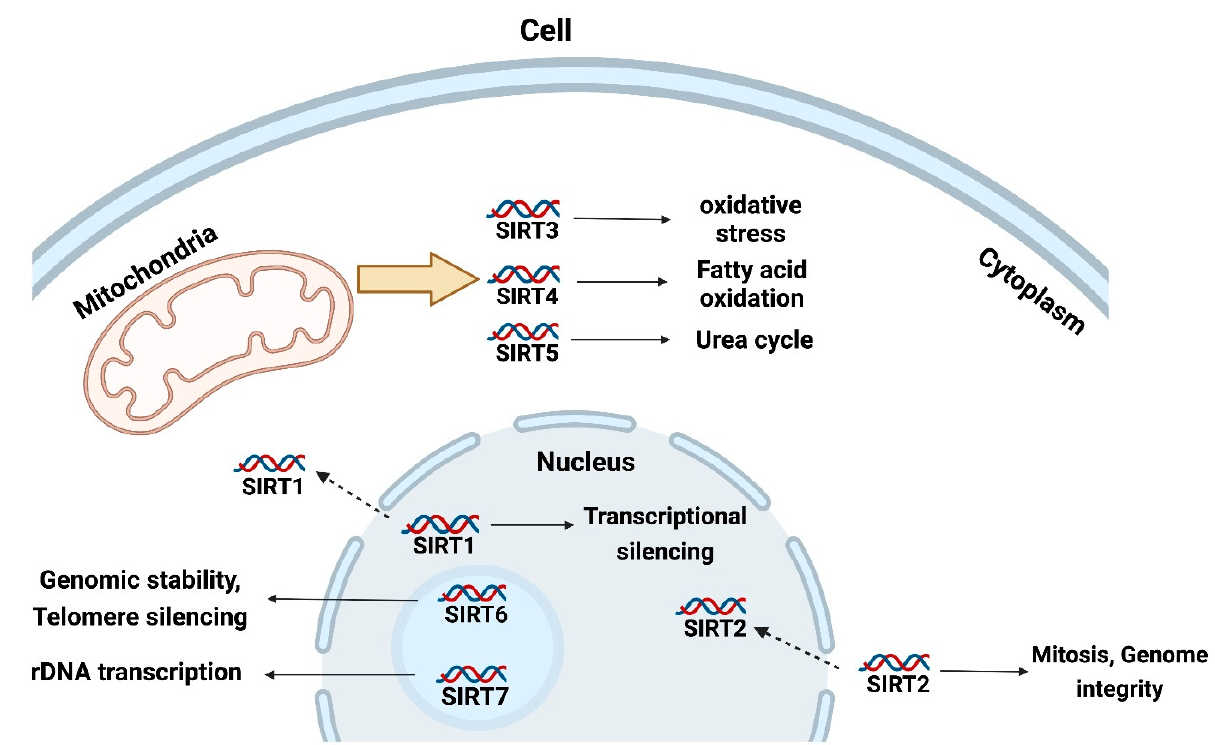
Figure 1. Main functions and subcellular localization of sirtuin family members.